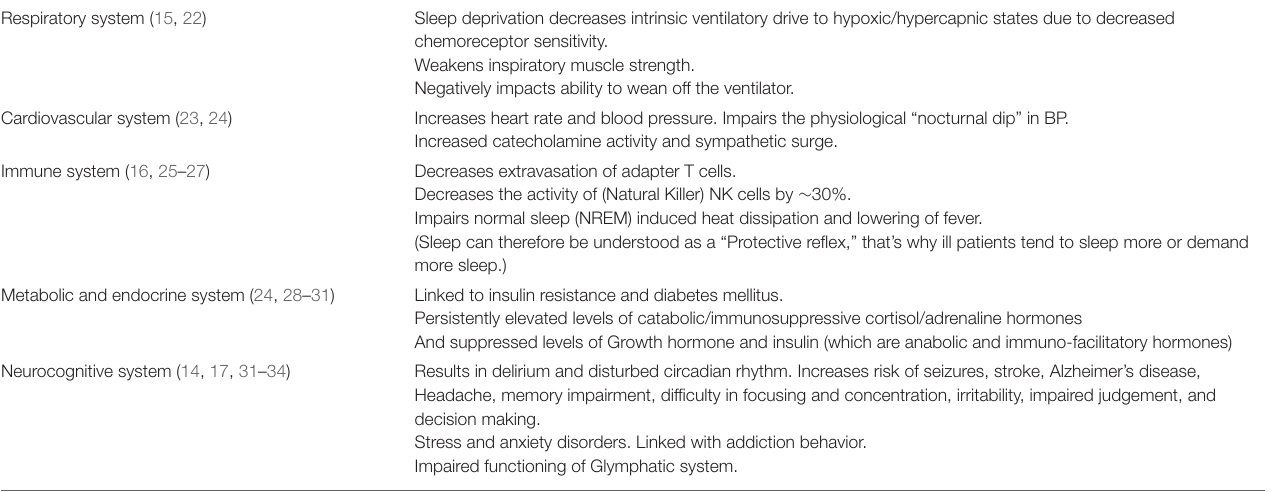
TABLE 2 | Pathophysiology of sleep deprivation on different systems. Respiratory system (15,